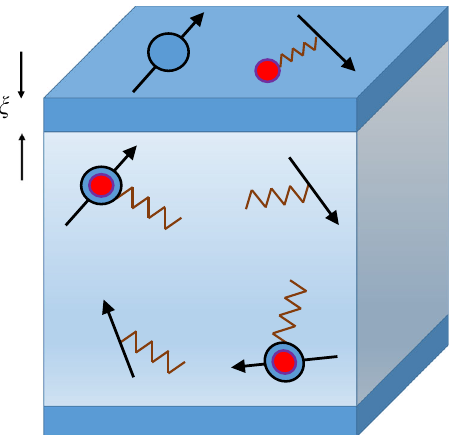
Fig. 2 Metallic surface with insulating CEFL bulk. The bulk realizes a CEFL, a compensated semi-metal with particle and hole-like pockets (as shown in Fig. 1c), that have both fCE and spinon-like character (see Fig. 1a, b for a carricature of the excitations). Upon approaching the surface, it possible for the fCE to unbind as a result of reduced U df / t d in a region of typical size ~ ξ , thereby liberating the d – electrons and holons, which may Bose condense. The latter leads to con fi nement and the resulting state is then a decoupled metallic surface. Only the top and bottom surfaces are shown for